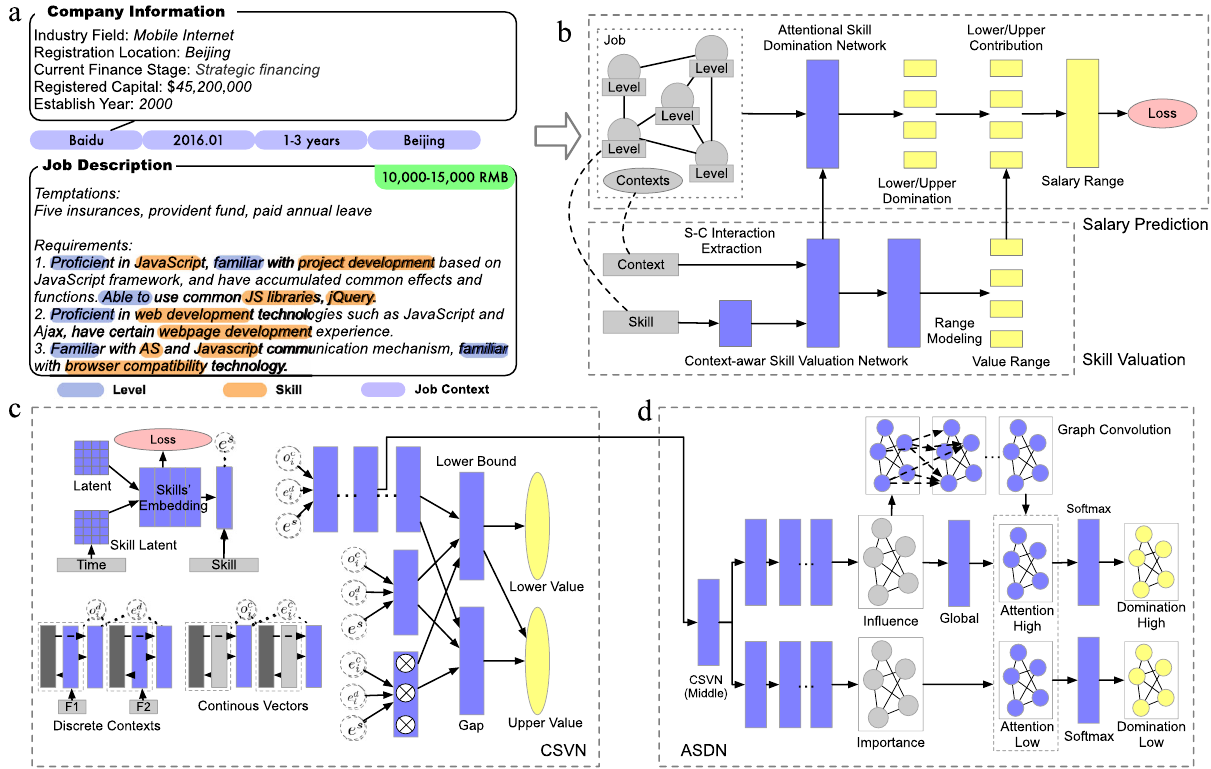
Fig. 2 A schematic diagram of SSCN based skill valuation framework. a An example of job posting in our data, which consists of some structured contextual information (e.g., company name, timestamp of publishing, work location, and required working experience), expected range of monthly salary (i.e., lower/upper bound in RMB), and detailed job description that introduces the requirements on candidates' job skills. In particular, each skill usually has a descriptive requirement on the degree of mastery, such as Pro fi cient in JavaScript , and Familiar with AS . b We formulate the job posting as a set of skills formed in a skill graph, and some contextual inputs. Our proposed SSCN estimates skill value and combines them into the job salary. The color gray, blue, yellow and pink indicate inputs, model structures, outputs, and loss functions, respectively. c The detailed structure of CSVN. d The detailed structure of